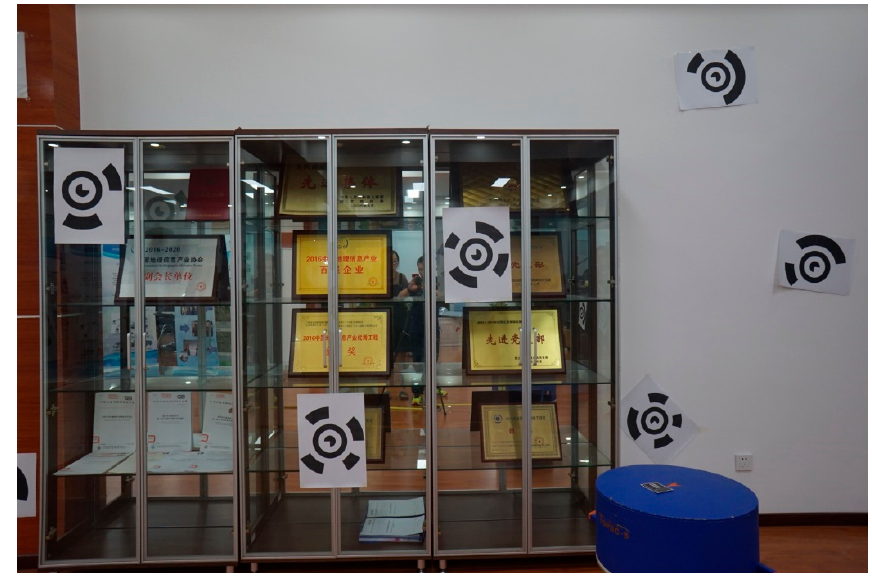
Figure 4. Coding Image.